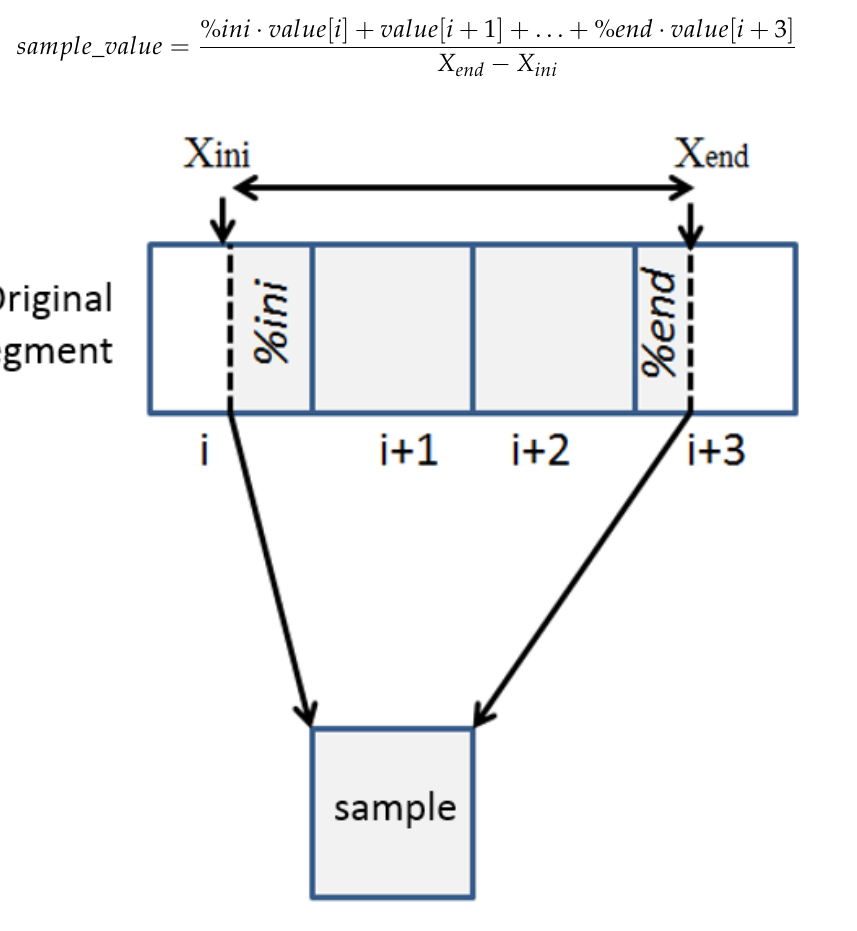
Figure 7. Sample value